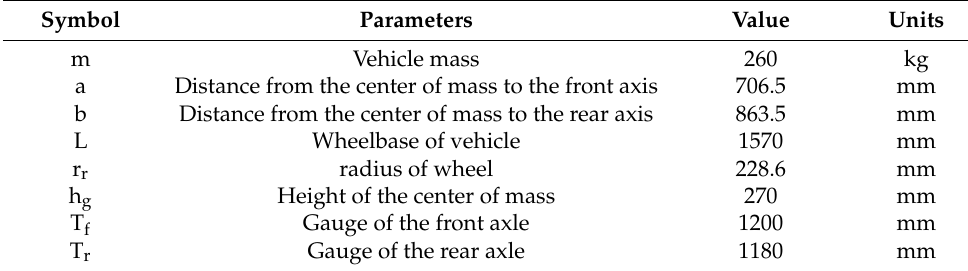
Table 1. Main parameters of the racing car.